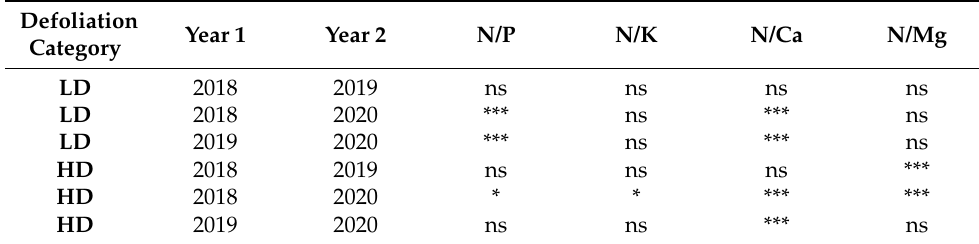
Table 3. Results of Holm pairwise comparisons of foliar nutrient ratios within a defoliation category and between sampling years (ns–not significant, * p < 0.05, *** p < 0.001).